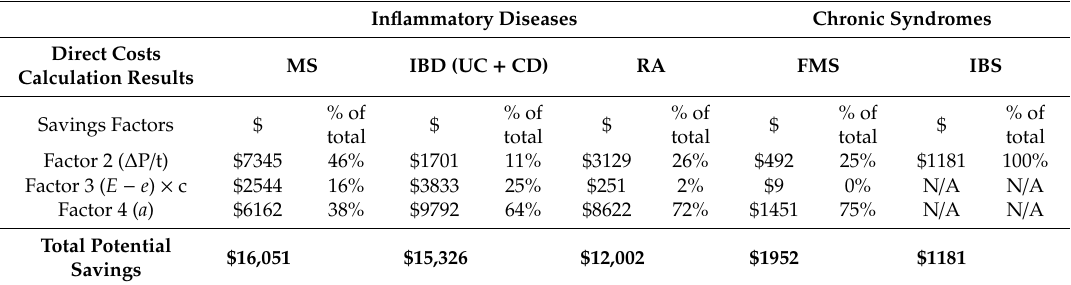
Table 4. Results of financial analysis equation with net positive savings factors